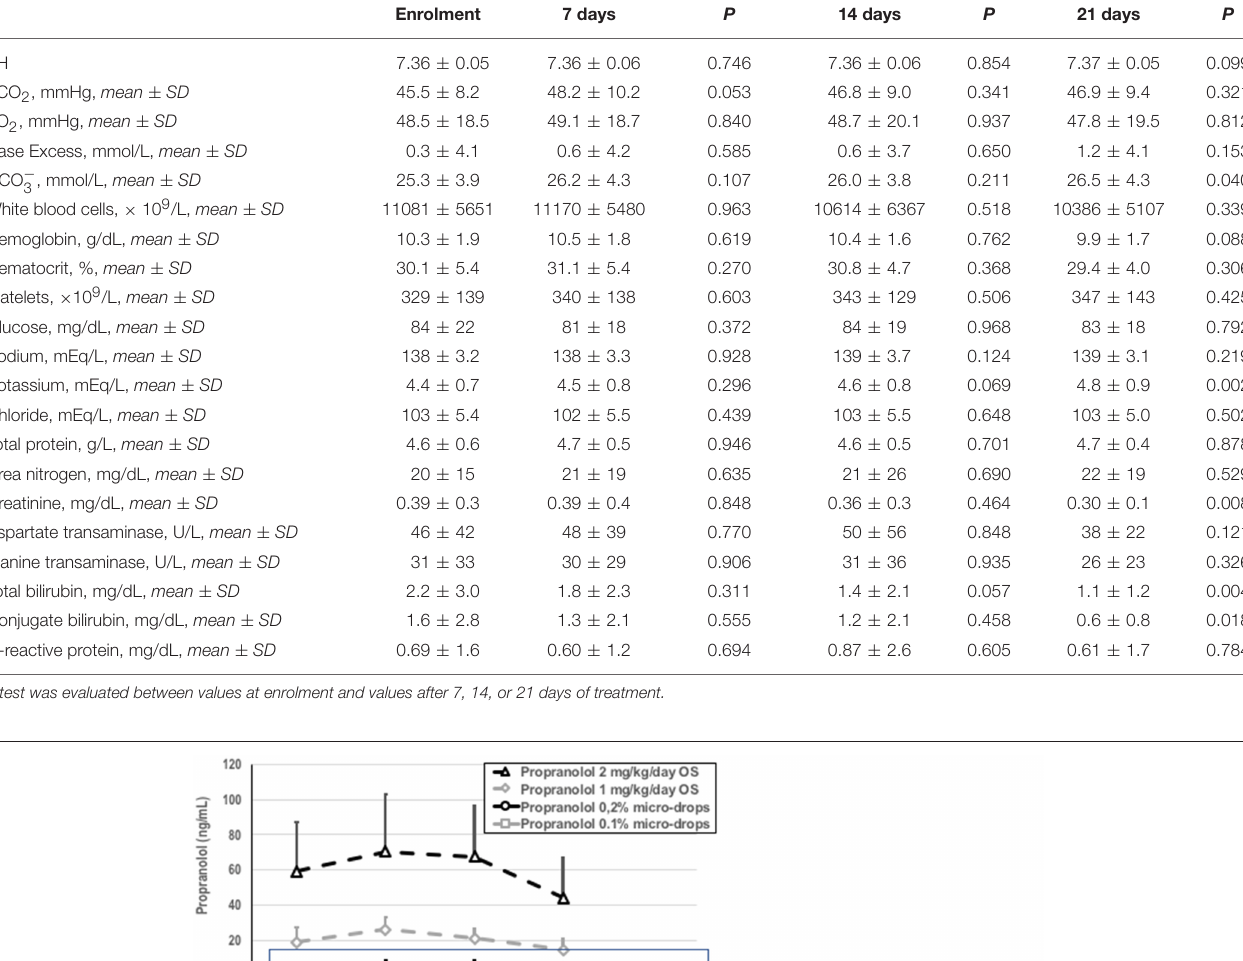
TABLE 2 | Biochemical parameters during the study of treated group.